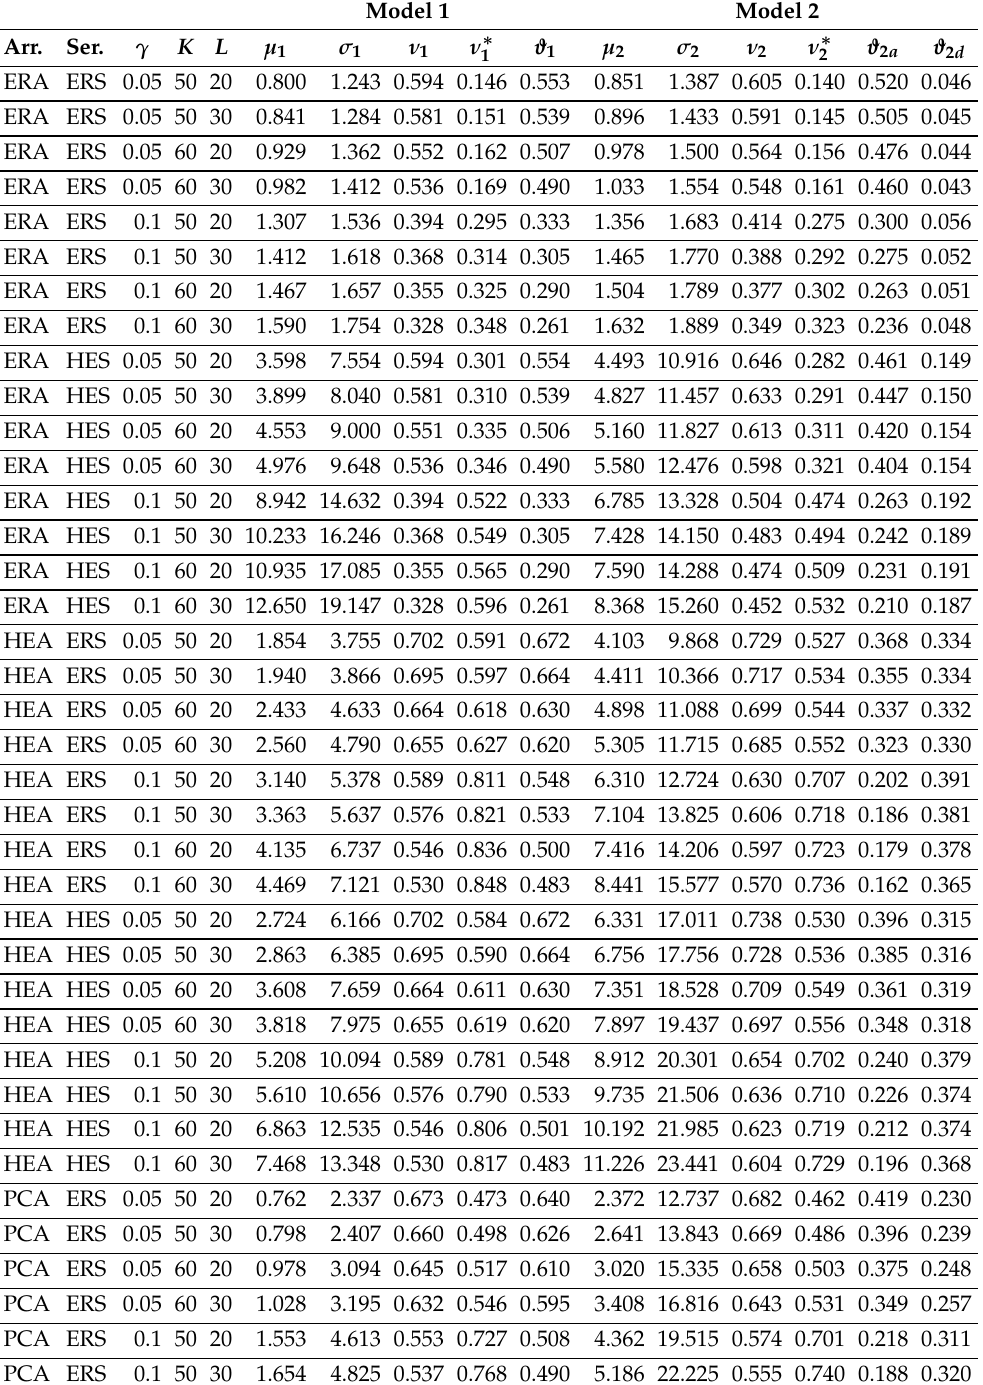
Table 1. Customer subsystem ( µ =